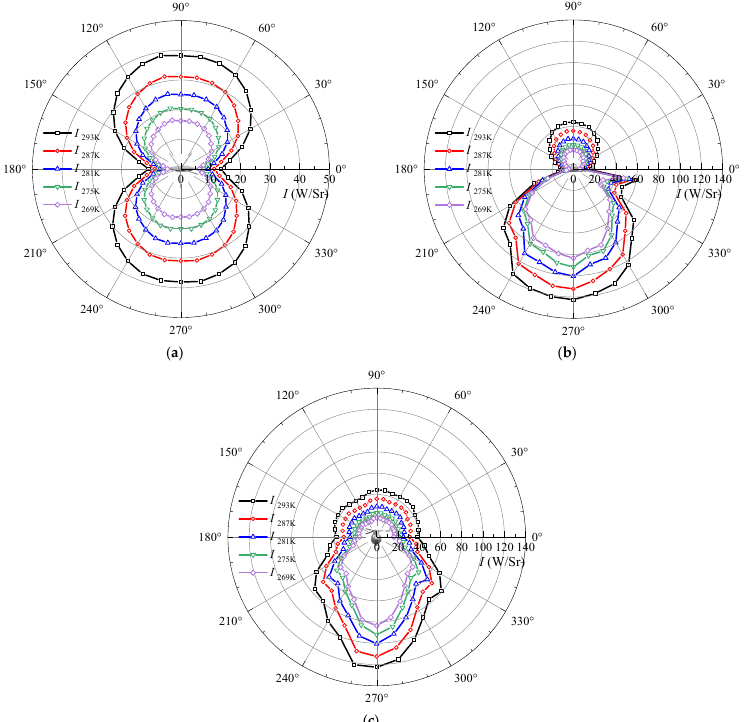
Figure 11. Infrared radiation intensity of the helicopter in 3–5 µm band. ( a ) XOY circle; ( b ) XOZ circle; and ( c ) YOZ circle. Aerospace 2023 , 10 , x FOR PEER REVIEW